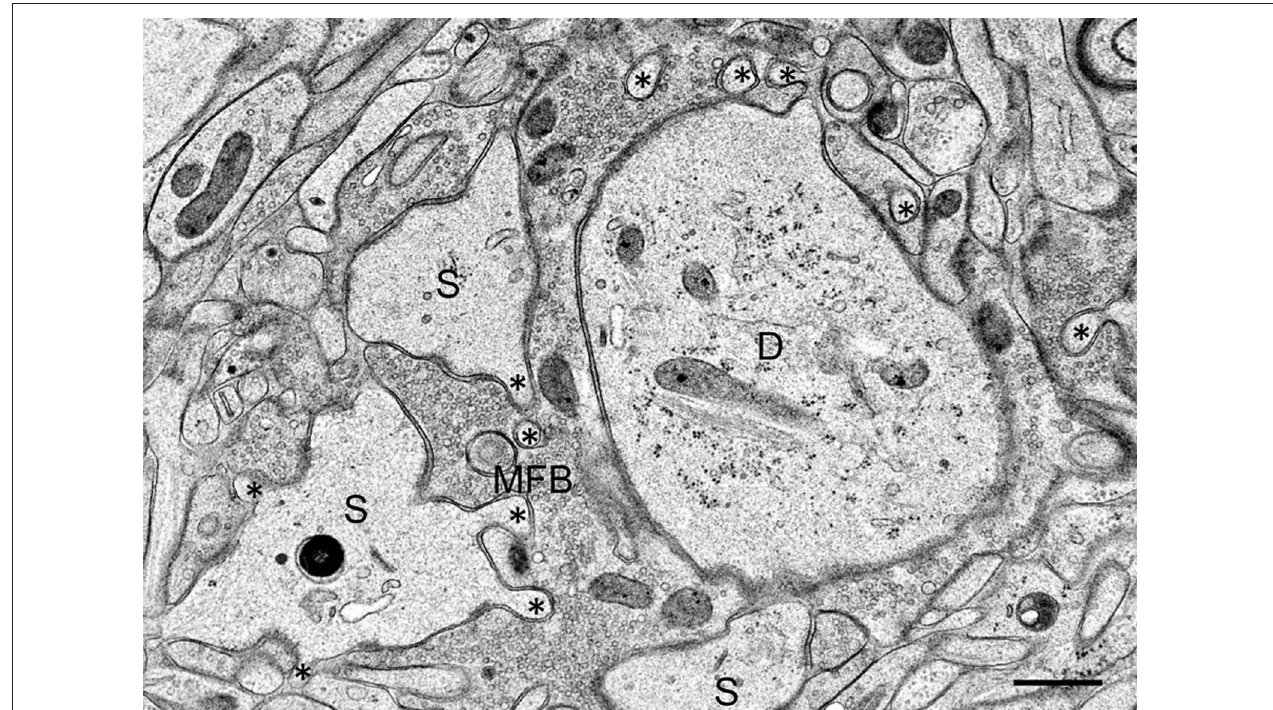
FIGURE 2 | Mossy fiber bouton (MFB) and its postsynaptic spines (S) in a hippocampal slice culture exposed to TEA for 10min prior to high-pressure freezing. Note finger-shaped small extensions (asterisks) emerging from the large complex spines. D, proximal CA3 pyramidal cell dendrite. Scale bar: 0.5 µ m.